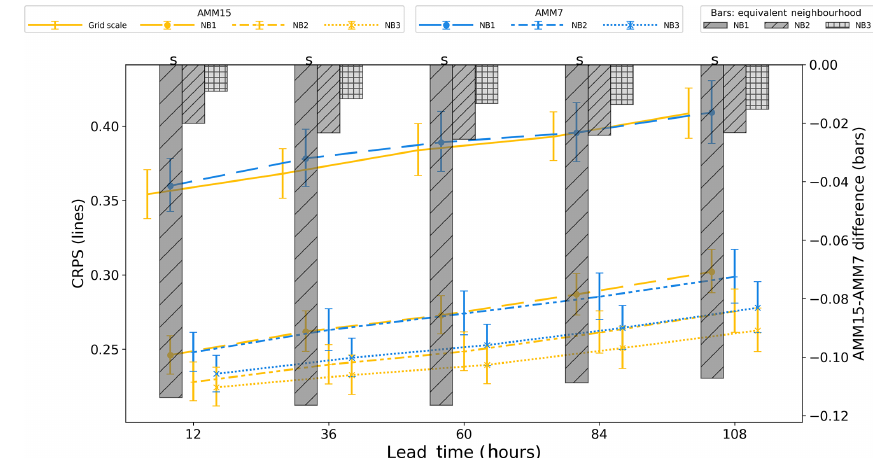
Figure 10. Summary of on-shelf CRPS (left axis, lines) and CRPS difference (right axis, bars) for the January 2019 to September 2019 period for AMM7 and AMM15 models at different neighbourhood sizes. Error bars represent 95% confidence values obtained from 10000 samples using bootstrap with replacement. An “S” above the bar denotes that 95% error bars for the two models do not overlap.